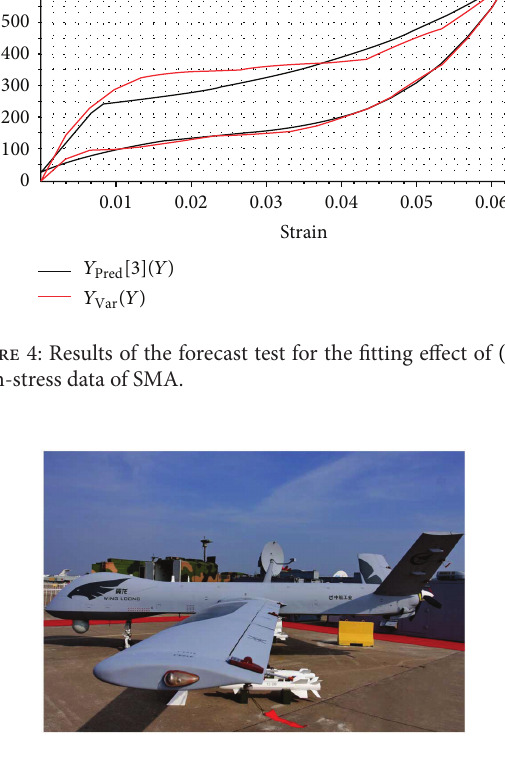
Figure 5: Chinese “Wing Loong”